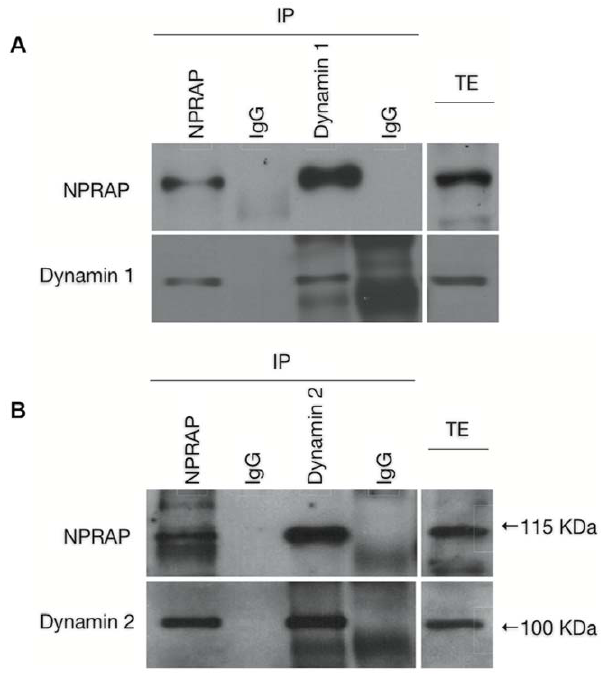
Figure 1. Co-immunoprecipitation of NPRAP and dynamins 1 and 2. As observed in the LC-MS/MS analysis, both dynamins co- precipitated with overexpressed NPRAP (A and B, lane 1, lower panels). Similarly, NPRAP was detected in the immunoprecipitations of dynamins 1 and 2 (A–B, lane 3, upper panels). Lanes 2 and 4 (A–B) correspond to mouse and goat serum IgG negative controls, respectively. Data are representative of at least three independent experiments. IP: immunoprecipitation; TE: total